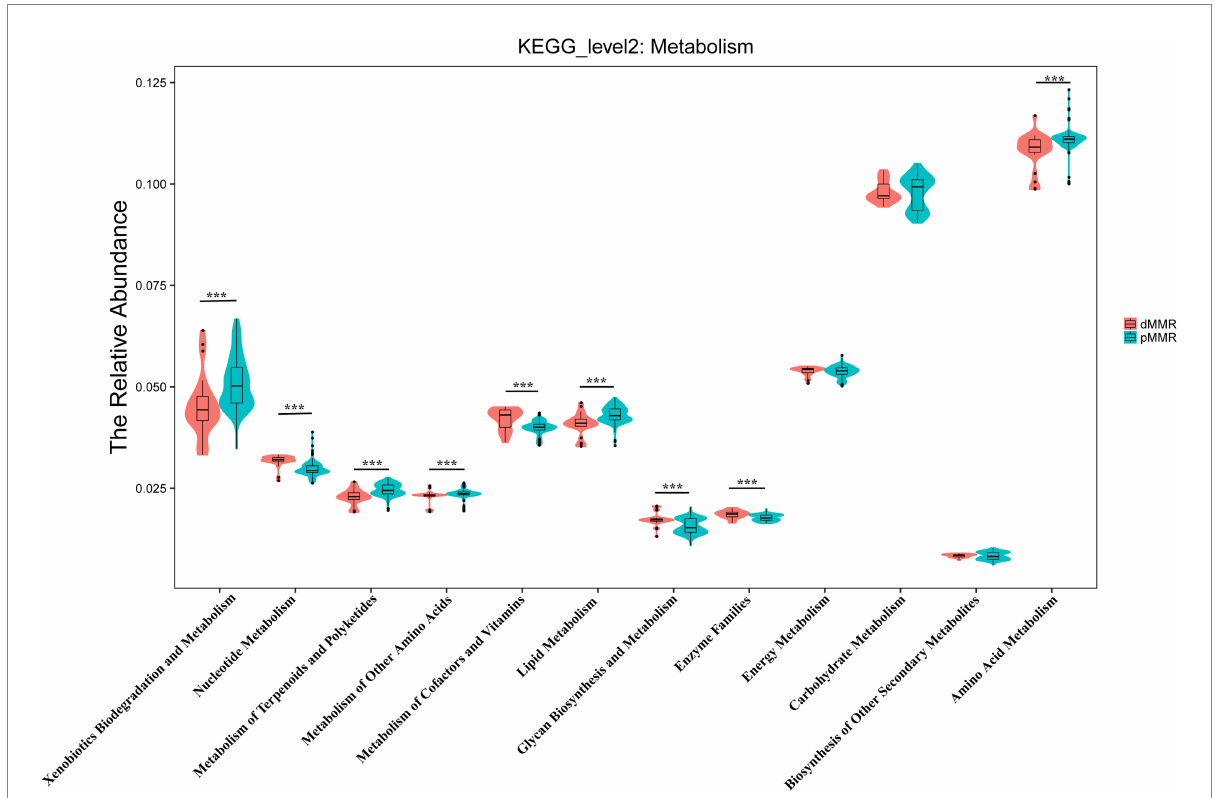
FIGURE 9 Predictive analysis of secondary metabolic functional pathways of intestinal flora between dMMR and pMMR patients. dMMR, dMMR tumor tissue samples (red); pMMR, pMMR tumor tissue samples (green). The abscissa represents the secondary functional groups of KEGG pathway, and the ordinate represents the relative abundance of samples. *** < 0.001. dMMR, deficient DNA mismatch repair; pMMR, proficient DNA mismatch